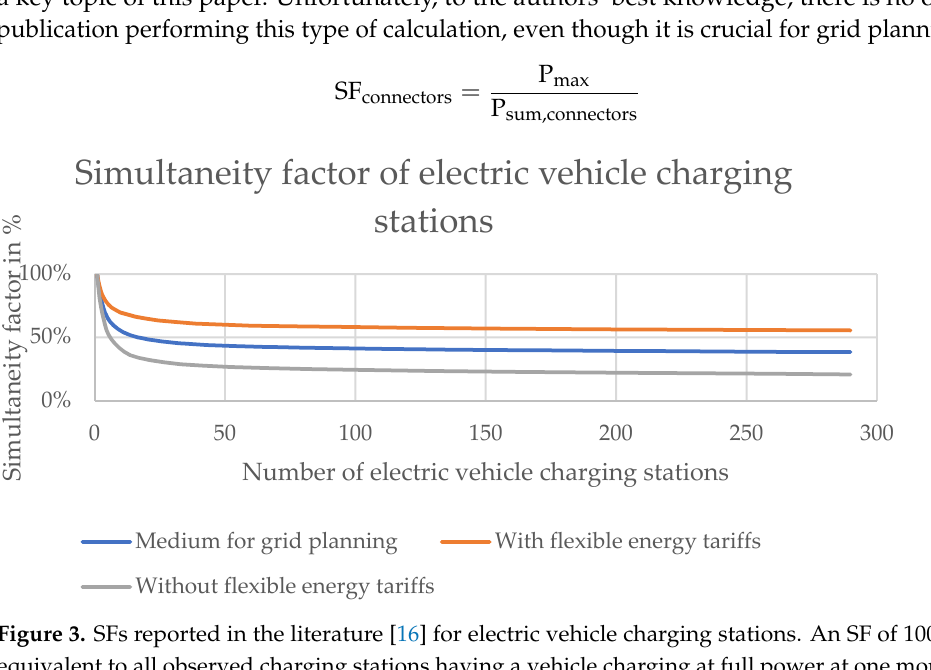
Figure 3. SFs reported in the literature [16] for electric vehicle charging stations. An SF of 100% is equivalent to all observed charging stations having a vehicle charging at full power at one moment in